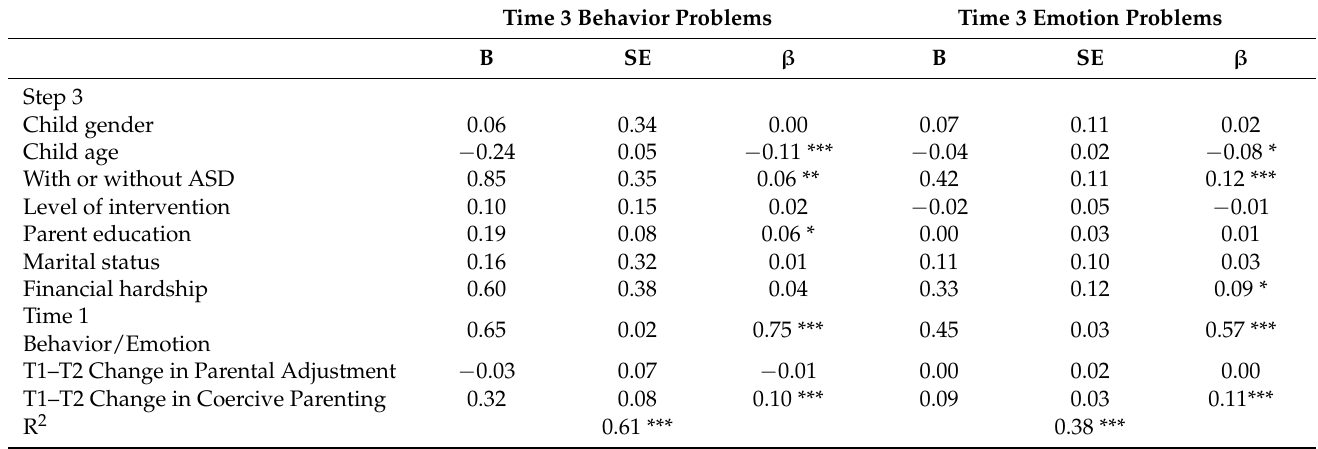
Table 5. Hierarchical multiple regression to predict child Behavior and Emotion problems at Time